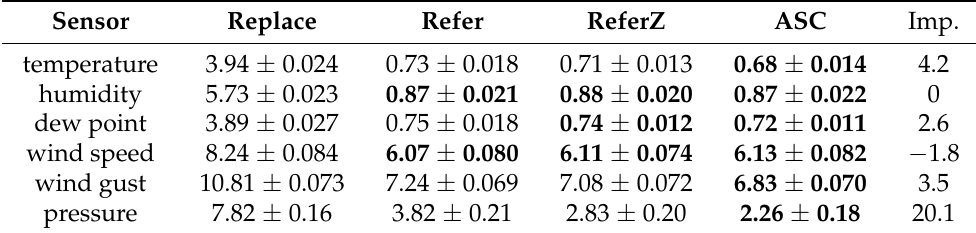
Table 2. Reconstruction errors (RMSE) on weather data for compound sensor changes. Each entry shows the average reconstruction error and the corresponding standard error. Imp. shows the average improvement (in %) of ASC over the best baseline method. The best performing method(s) (statistically significant up to one standard error) are in bold font.